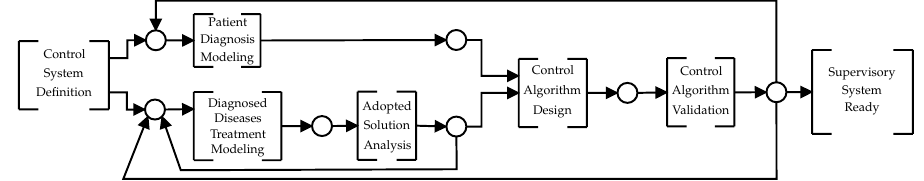
Figure 6. PFS model of the proposed safe control system design method for